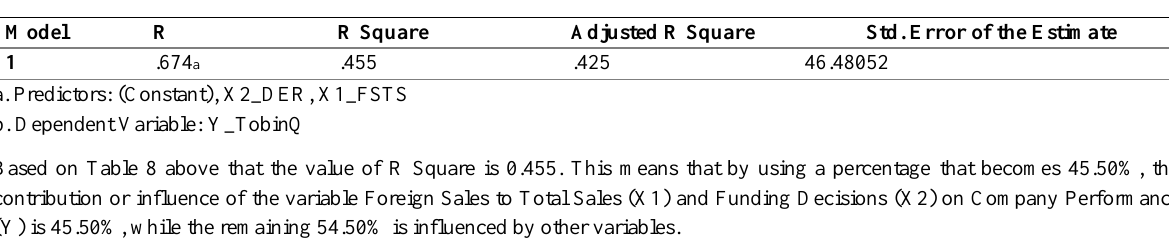
Table 8: The Coefficient of Determination